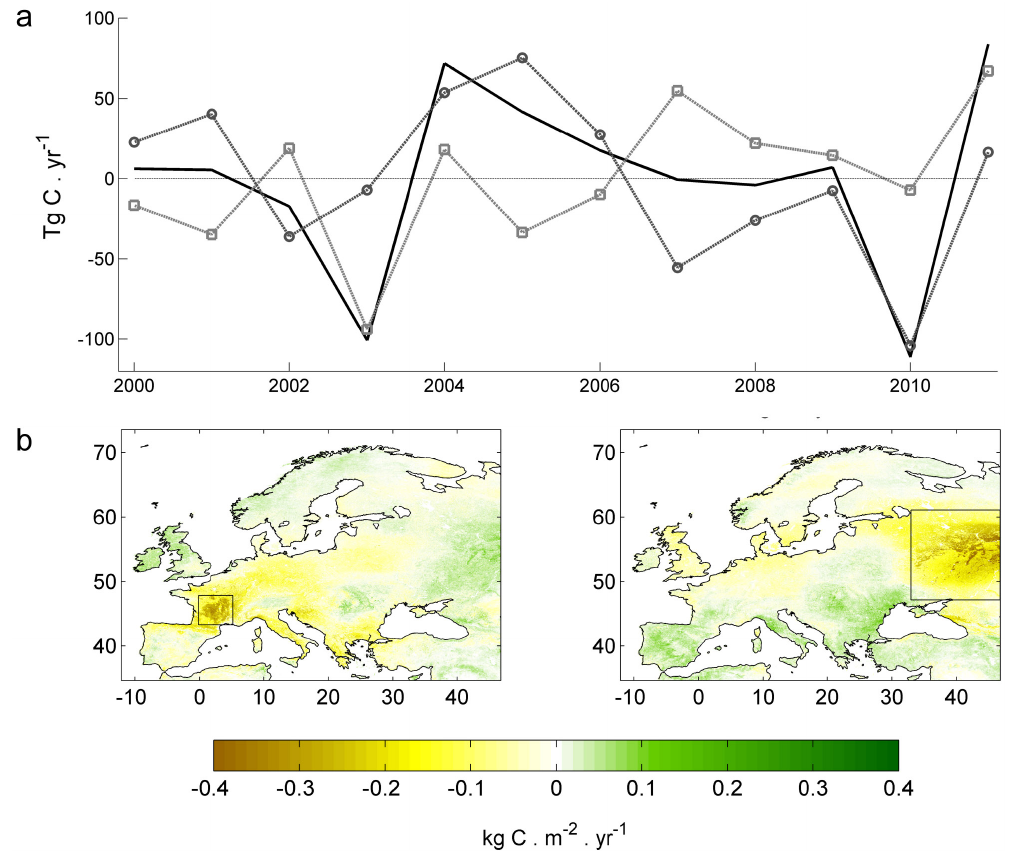
Figure 1. Annual NPP anomalies over Europe: (a) integrated NPP anomaly between 2000 and 2011 for Europe (solid black), western Europe (light grey dashed, circles) and eastern Europe (dark grey dashed, squares); (b) NPP anom fields for 2003 (left) and 2010 (right). The dashed lines in (b) separate the western and eastern European sectors used to compute the time series in (a) . The reference period 2000–2011 excluding each year (2003 or 2010), to avoid the bias effect on the average of the extremely low values registered during the heatwaves. Annual NPP are derived from the MOD17A3 algorithm (Running et al., 2004) using daily meteorological data from the NCEP/DOE II